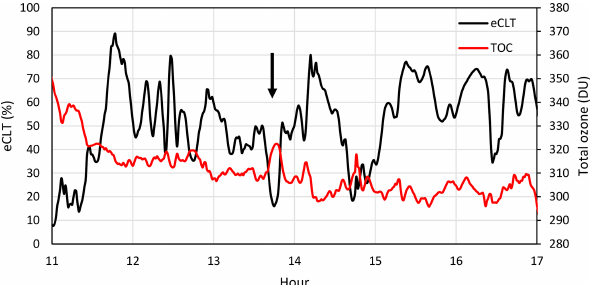
Figure 4. Total ozone and eCLT during 1d (9 September 2018) with heavy clouds at Blindern, University of Oslo. Black arrow indicates a time where eCLT drops below